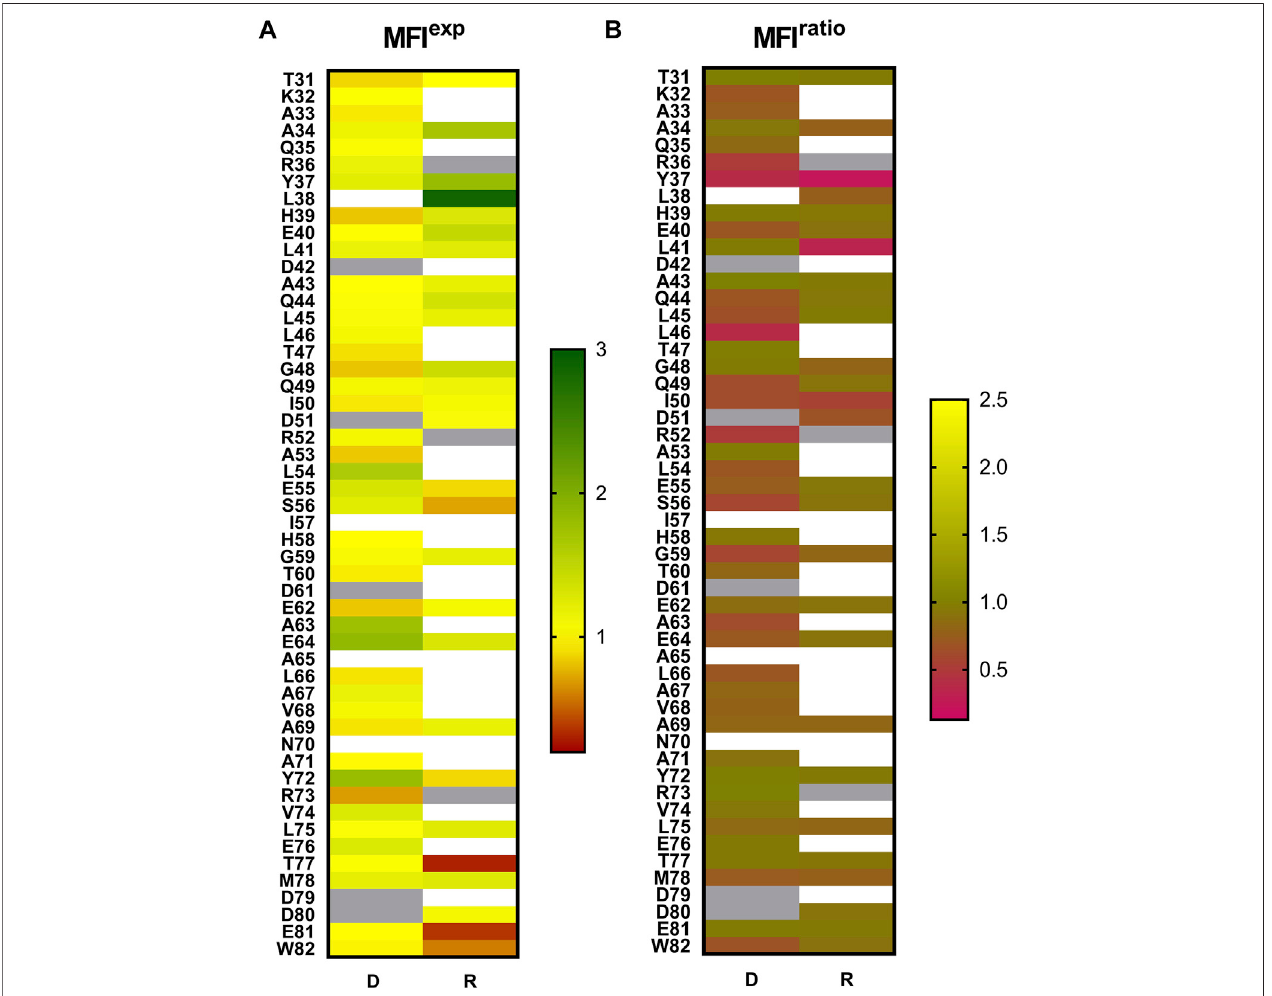
FIGURE 3 | Mutational effects in MazE6 depicted as heatmaps. (A) The normalised expression scores of mutants, MFI exp (cid:1) expression MFI(mutant)/ expression MFI(WT). The MFI exp scores describe the expression levels of MazE6 proteins on yeast cells with respect to WT. (B) Normalised MFI ratio (cid:1) binding: expression ratio MFI (mutant) /binding: expression ratioMFI (WT), where binding: expression ratio MFI isthe mean Alexa 633:Alexa 488 fl uorescence intensity ratio, illustrated inheatmap for the investigated MazE6 substitutions to aspartate and arginine. The MFI ratio scores help distinguish the interaction of surface displayed MazE6 mutants to puri fi ed WT MazF6, with respect to the WT construct of MazE6. The mean of two replicates has been plotted here in the heatmap. The blank cells indicate mutants where the mutant was not made. Grey cells indicate WT residues. In all cases, normalization is with respect to WT values.